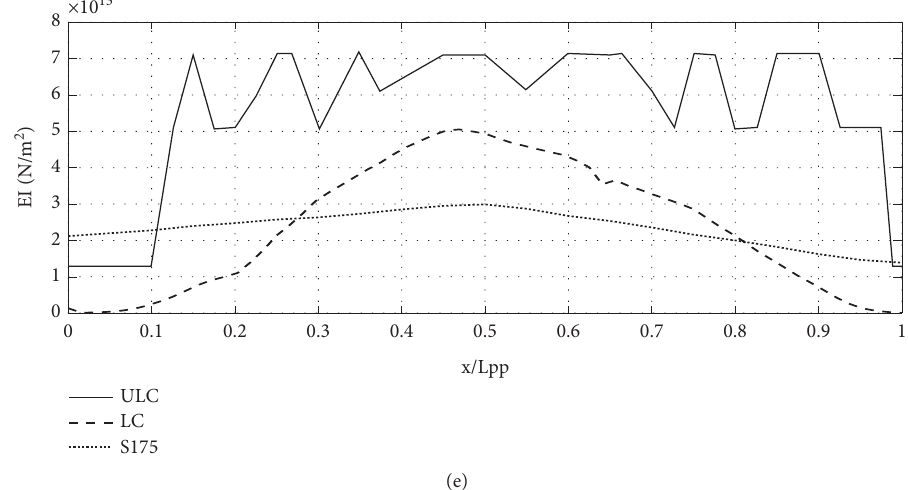
Figure 4: Body plan and hydrodynamic idealisations for different container ship models. (a) Ship 1: S175. (b) Ship 2: LC. (c) Ship 3: ULC. (d) Mass distributions. (e) Flexural rigidity